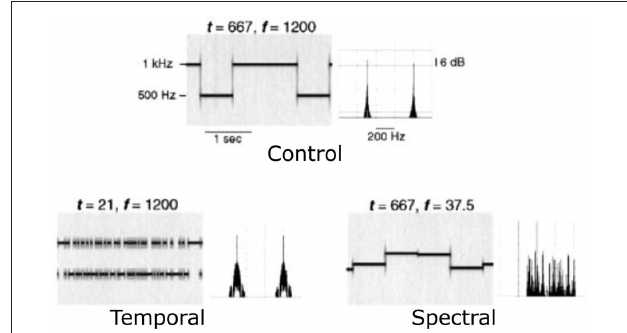
(frequency as a function of time) and on the right as a Fourier spectrum (amplitude as a function of frequency). The top pair of panels shows the control stimulus: two tones with a frequency separation f of 1200 cents (one octave) with the fastest temporal change of t = 667 ms. The bottom two panels represent temporal and spectral conditions. The figure is adapted from Zatorre and Belin (2001) with permission